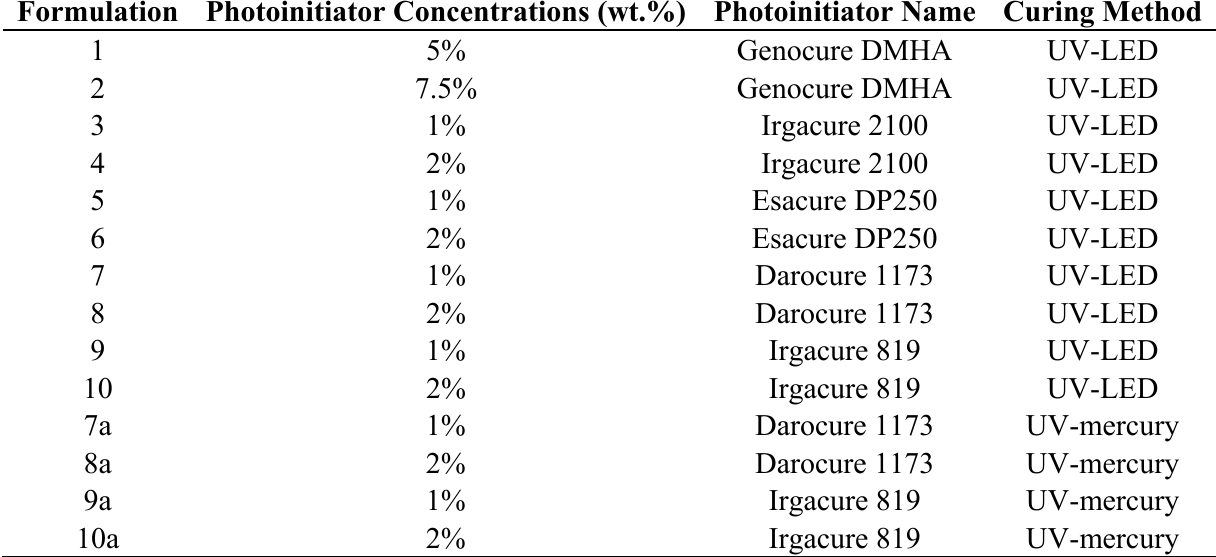
Table 3. Photoinitiator concentrations (in wt.%) for each water-based formulation and the curing method